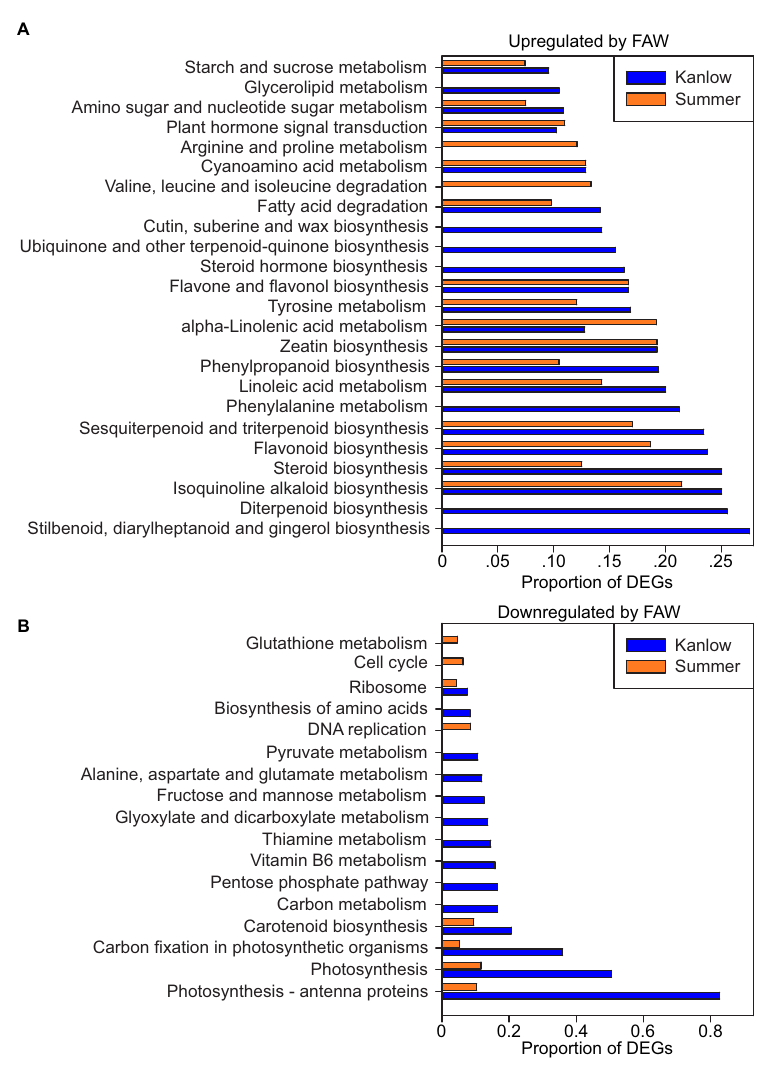
Fig 3. KEGG pathway enrichment in DEGs. (A) KEGG pathway significantly enriched (FDR < 0.05) in gene sets upregulated by FAW in Kanlow (blue) and Summer (orange) switchgrass. If the pathway was enriched, the proportion of DEGs in the gene set relative to the total number of expressed genes in the pathway is shown on the x-axis. (B) KEGG pathway significantly enriched (FDR < 0.05) in gene sets downregulated by FAW in Kanlow (blue) and Summer (orange)